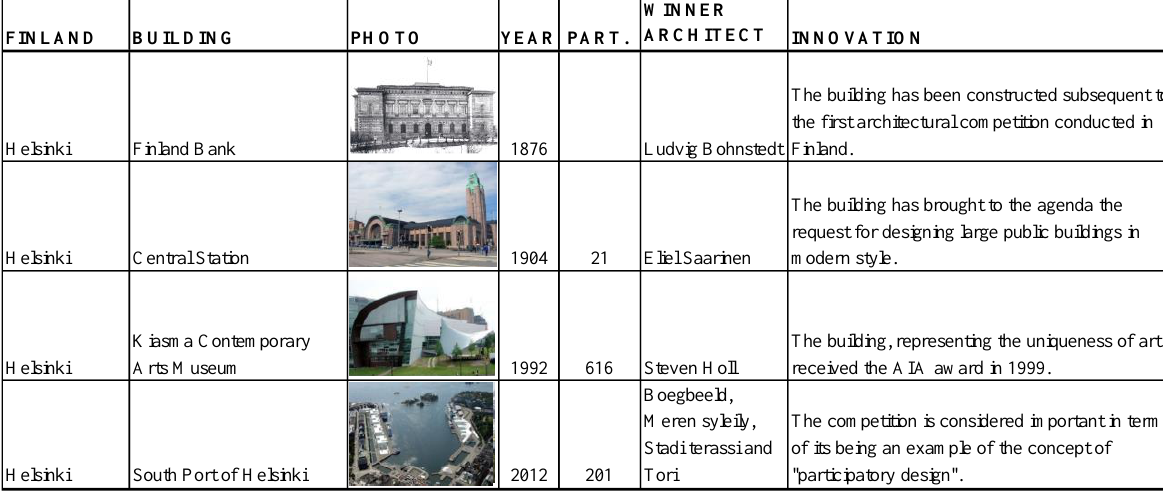
Table 4. Selected competition examples from Finland